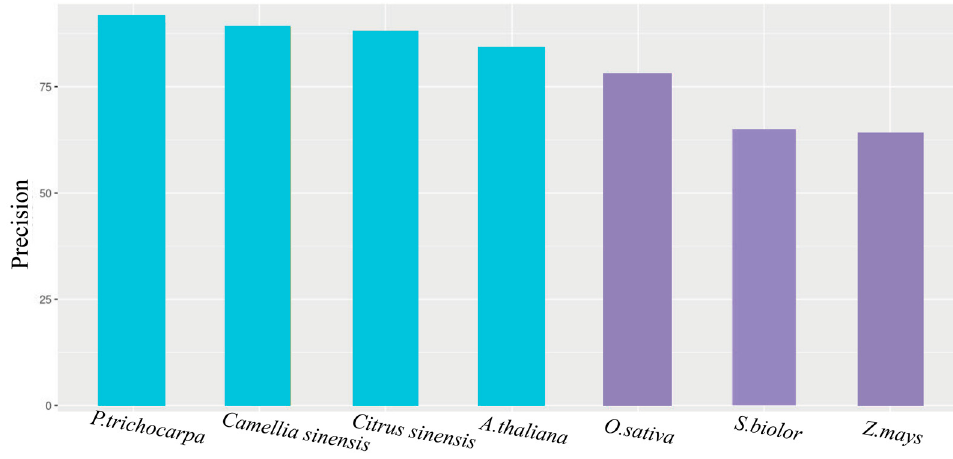
Figure 6 . The testing performance in predicting OGs of various angiosperm species. The precision of predicting OGs for different angiosperm species was not the same, indicating a higher reliability of XGBoost-A2OGs in identifying OGs of eudicot species ( P. trichocarpa , Camellia sinensis , Citrus sinensis , and A. thaliana ) than that of monocot